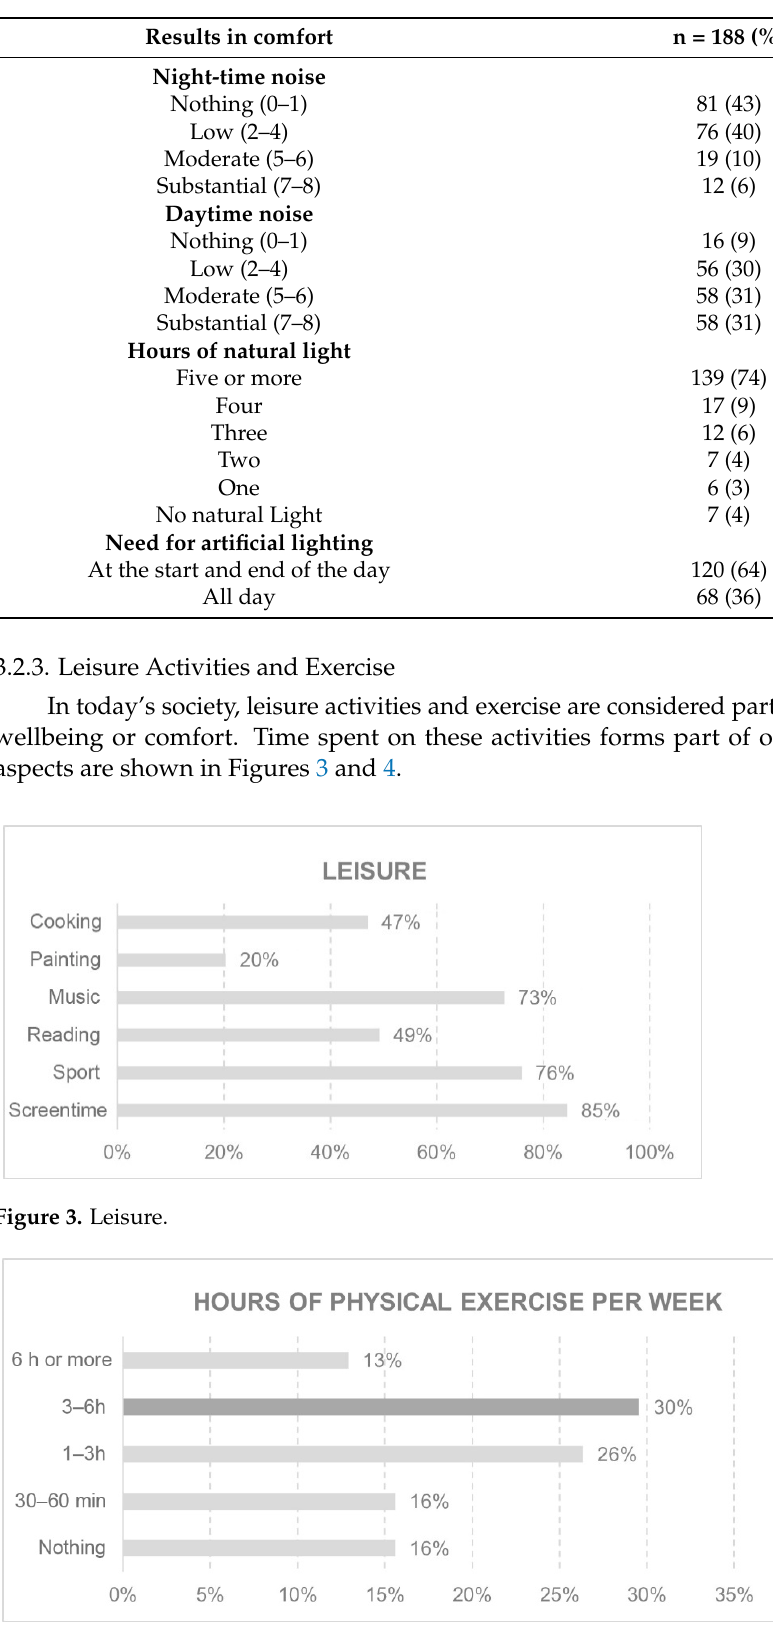
Table 3. Results in